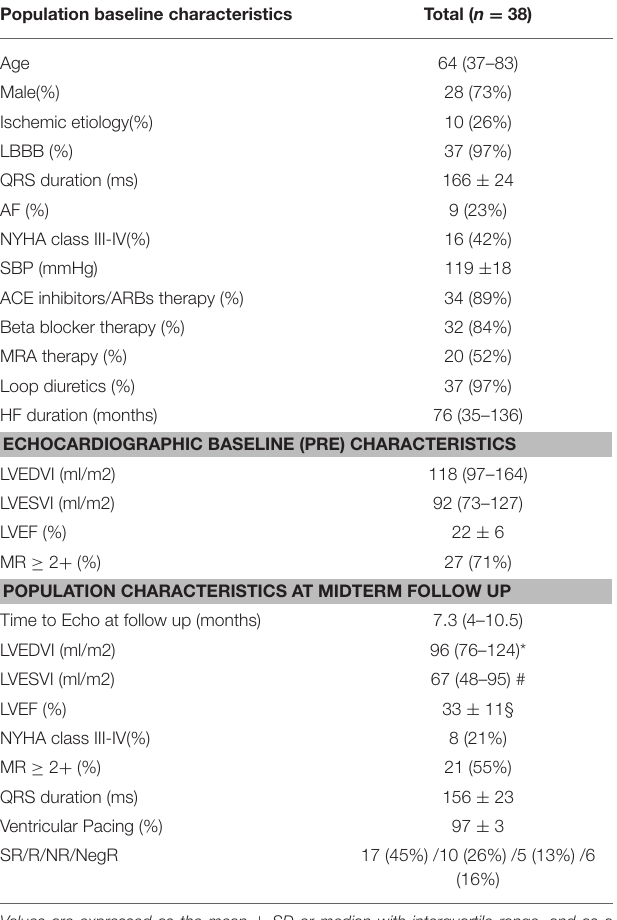
TABLE 1 | Population characteristics and main echocardiographic data at basal and midterm follow up. Population baseline characteristics